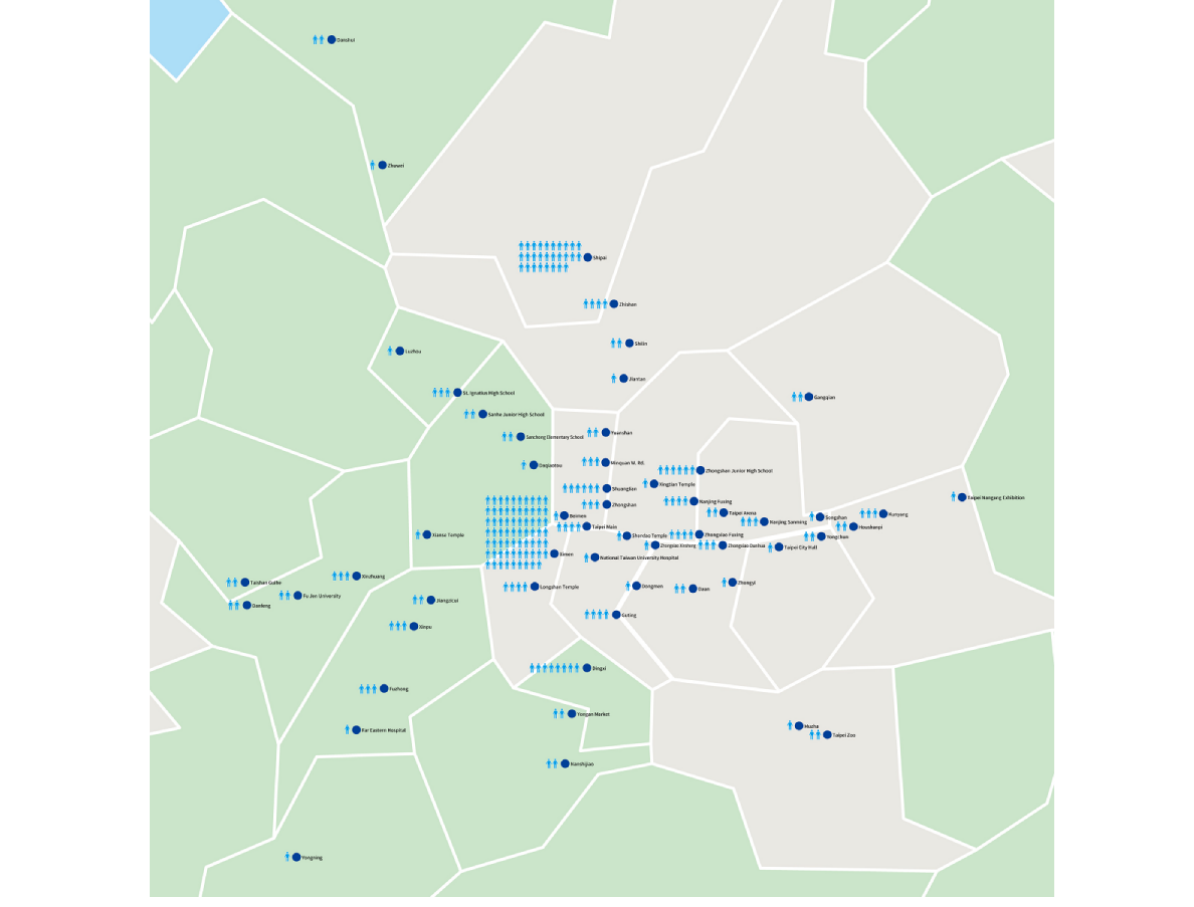
Figure 4. The distribution of tested men who have sex with men in social networking voluntary counseling and testing model in Taipei and New Taipei